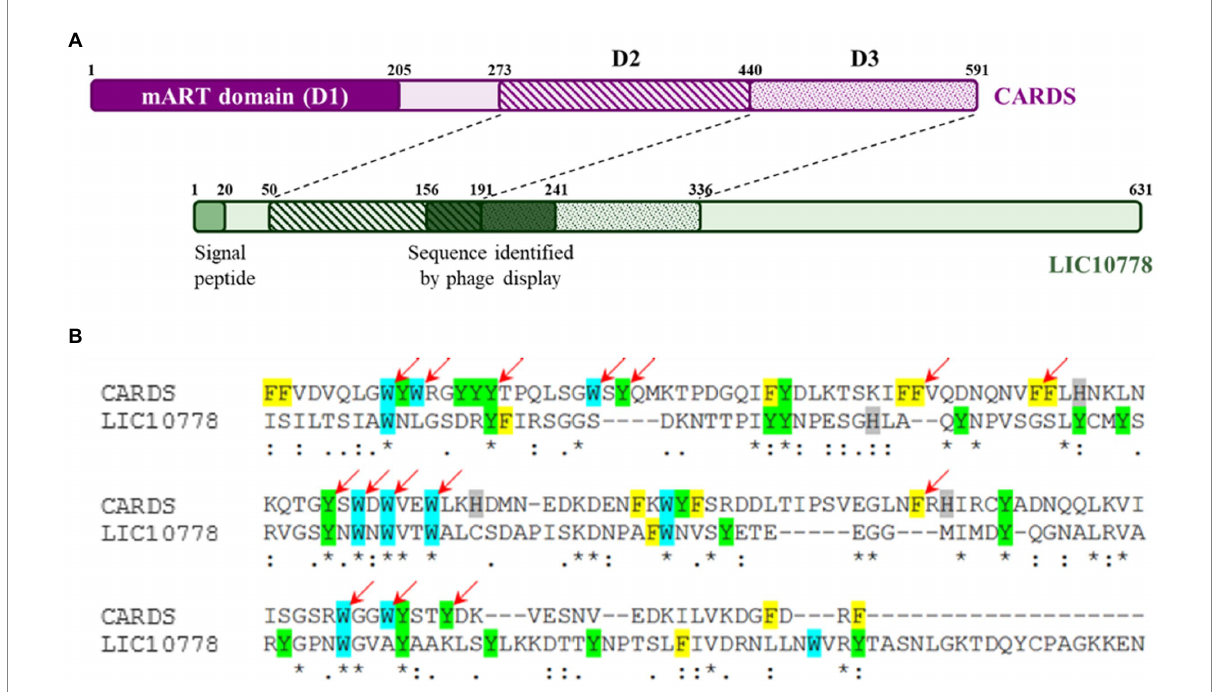
FIGURE 3 LIC10778 alignment with CARDS toxin. (A) Schematic representation of CARDS toxin from Mycoplasma pneumoniae (in purple) and its D2 and D3 domains aligned with LIC10778 protein (in green). (B) Alignment detail of CARDS toxin D3 domain with LIC10778 sequence (191–336 aa), where the aromatic residues are highlighted in yellow (phenylalanine), cyan (tryptophan), green (tyrosine) or grey (histidine). Red arrows indicate residues that form the “aromatic patch,” essential for CARDS toxin-binding and internalization function in